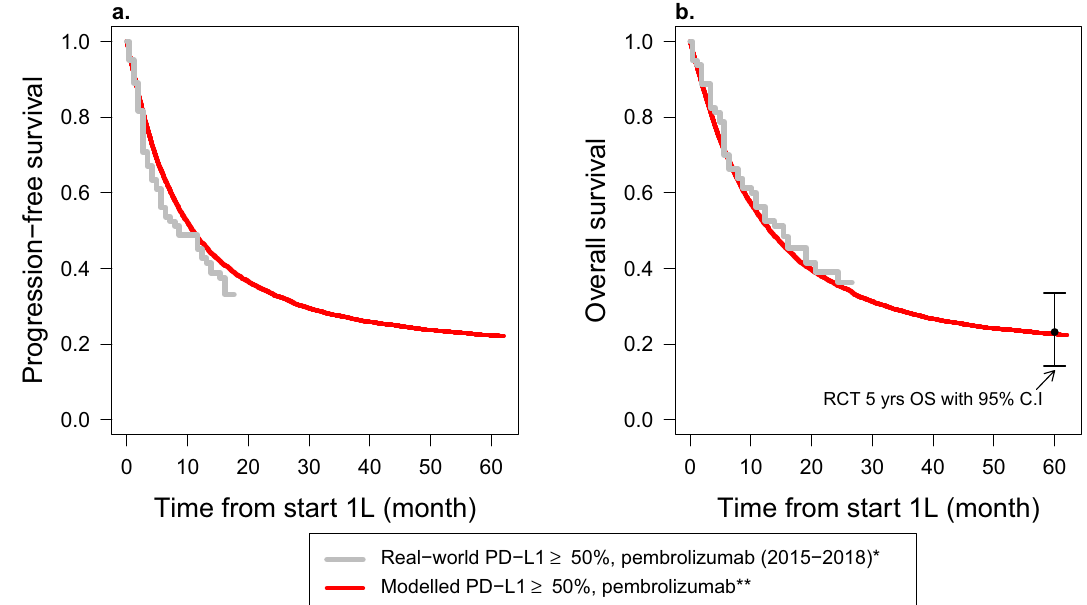
Figure 5. Comparison of modelled and real-world progression-free survival ( a ) and overall survival ( b ) curves for patients with high programmed death ligand 1 (PD-L1 ≥ 50%) expression and treated with first- line pembrolizumab monotherapy. *Reconstructed (digitized) progression-free and overall survival data of 83 patients diagnosed and treated between 2015 and 2018 in Santeon hospitals 19 . **The modelled data was simulated assuming a hazard ratio of 0.5 for pembrolizumab compared to chemotherapy 38 and a long-term survivor fraction of 23 percent 56 . The black dot and interval bar (RCT 5-yr OS with 95% C.I) indicates a five- year overall survival with 95% confidence interval from Keynote-001 56